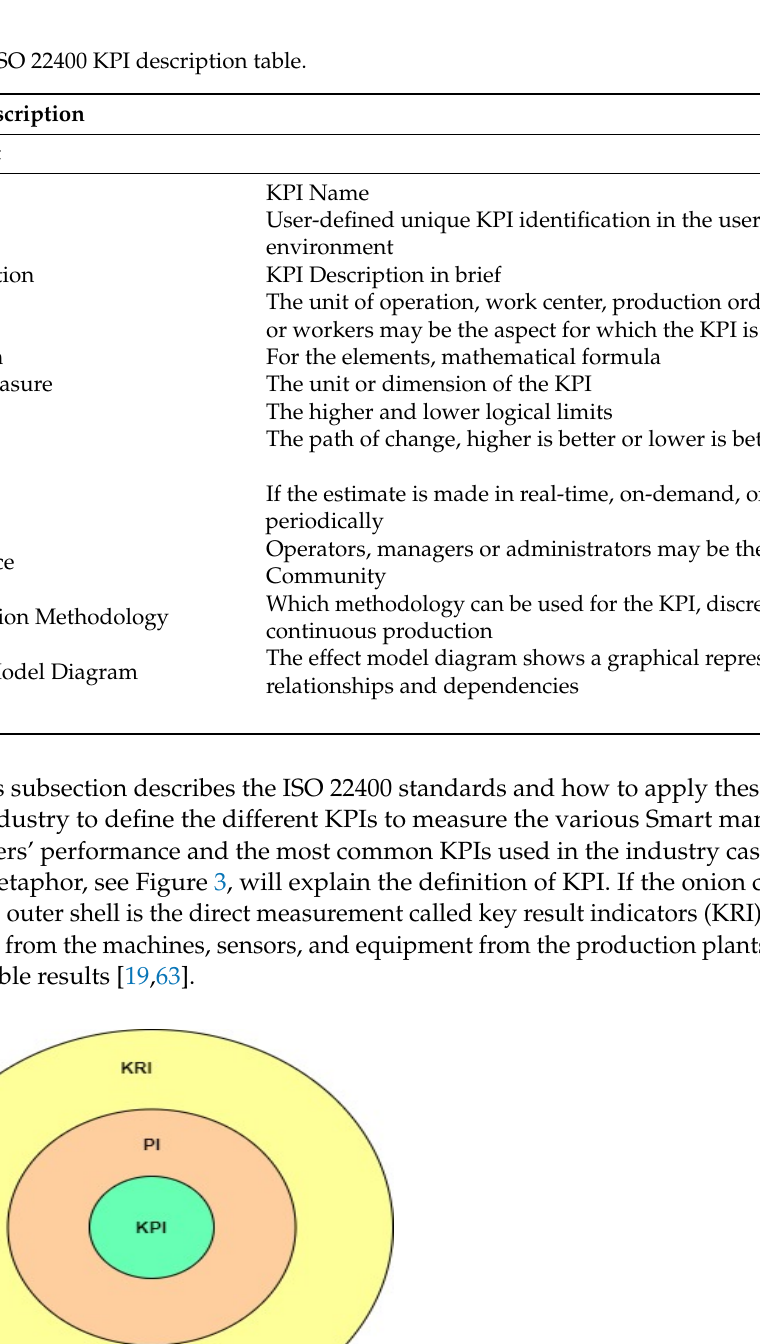
Table 3. Most Common KPIs used in industry.